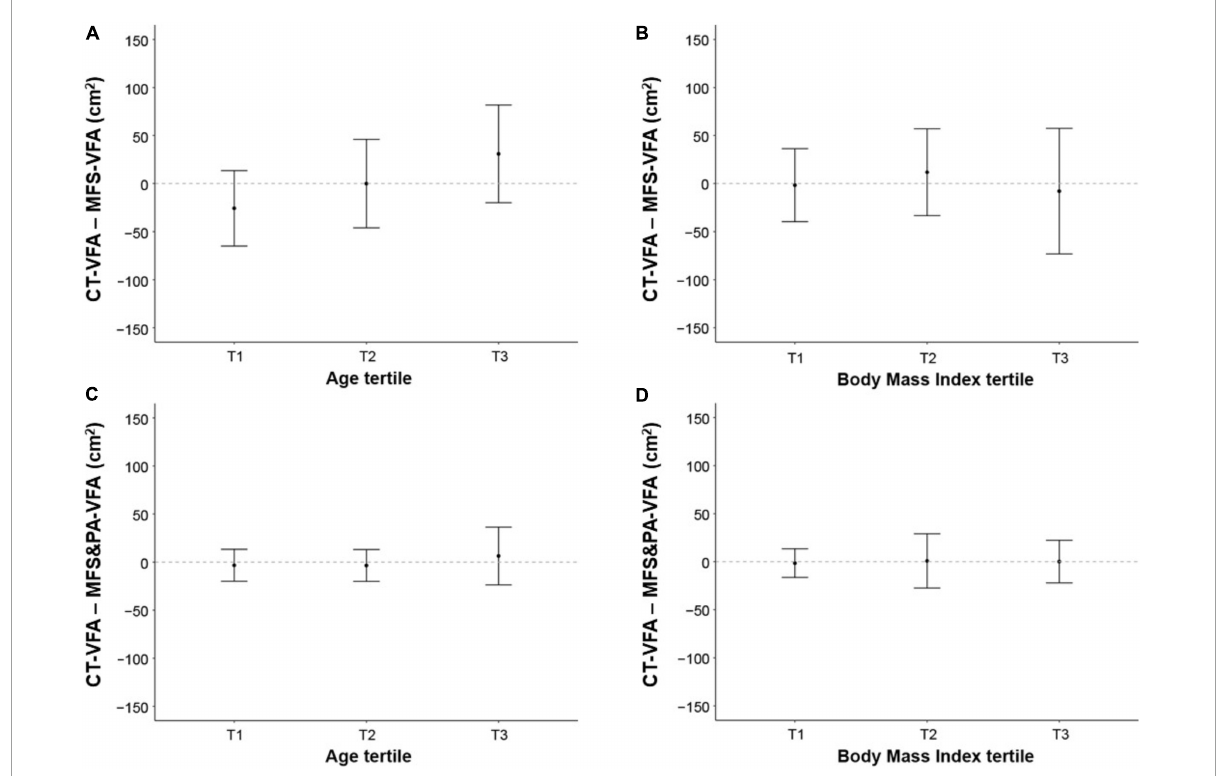
FIGURE3 Differences in VFAs between two methods according to (A,C) age and (B,D) body mass index subgroups. Data are indicated as mean ± SD. CT, computed tomography; VFA, visceral fat area; CT-VFA, VFA measured by CT; MFS-VFA, VFA measure by a multifrequency segmental bioelectrical impedance analysis (BIA) (InBody770 R (cid:13) ); MFS&PA-VFA, VFA measured by a new MFS-BIA machine combined with a portable abdominal BIA device (InBody970 R (cid:13) + Y-scope R (cid:13)